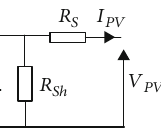
Figure 1: PV cell equivalent circuit. Table 1: Speci fi cations of PV